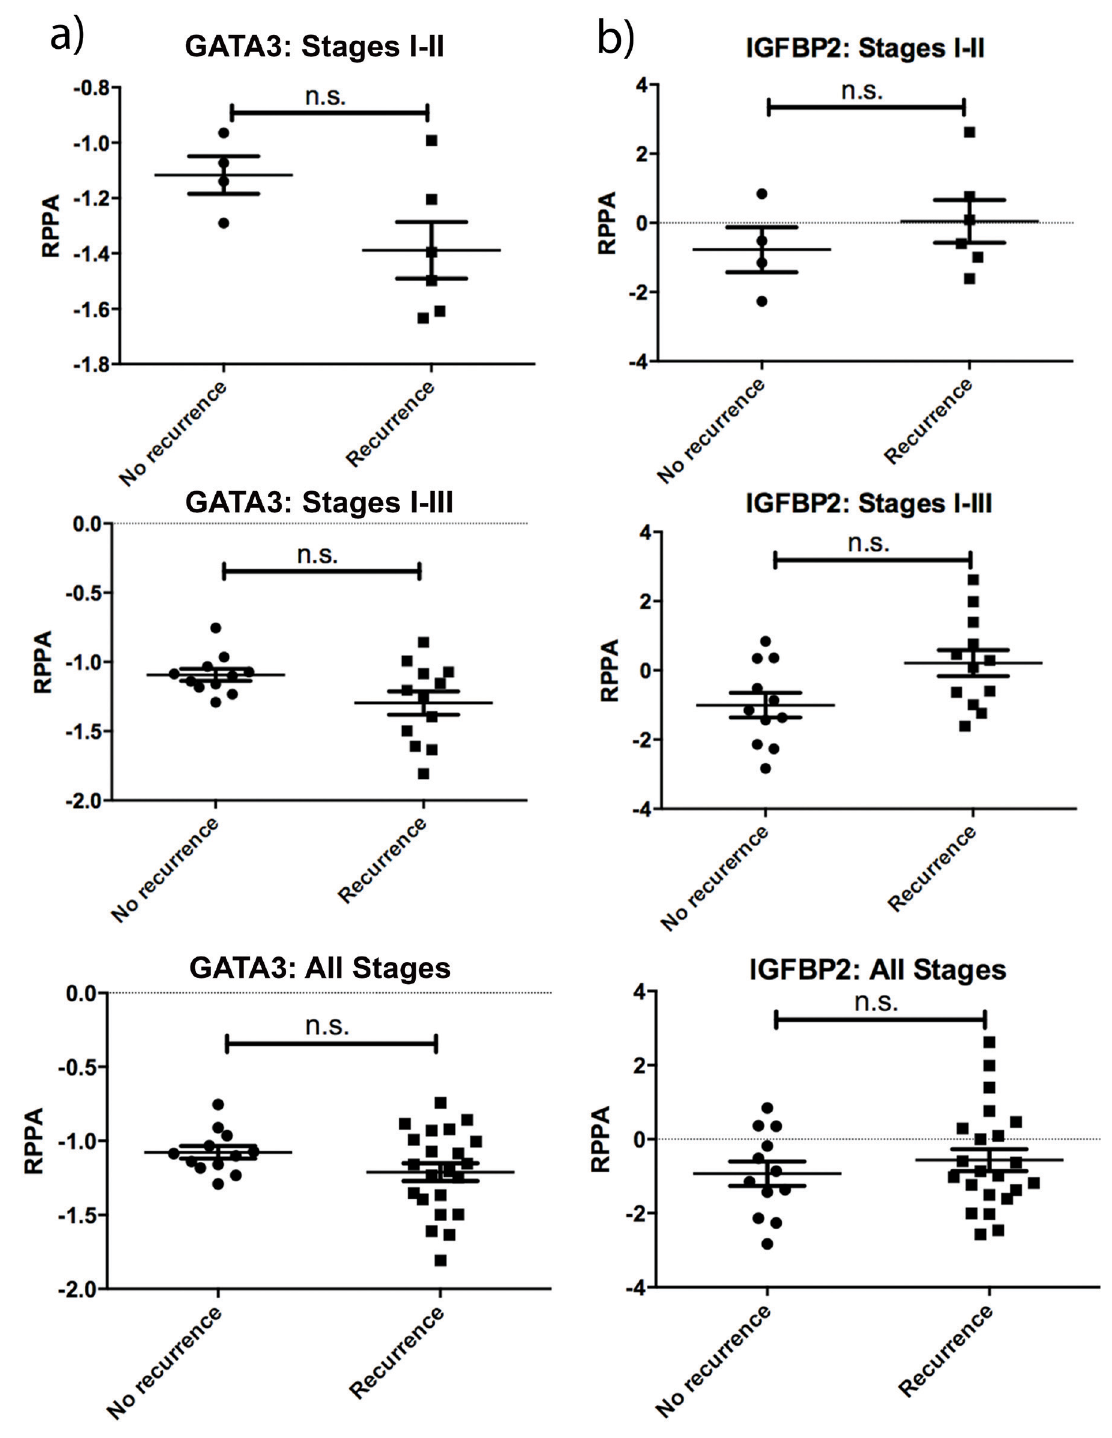
Supplemental Figure 2. Comparison of RPPA-determined expression in non-recurrent and recurrent patient tumors for GATA3 and IGFBP2. Decreased GATA3 ( a ) and increased IGFBP2 ( b ) expression are evident in recurrent patient tumors, but the data were not significant